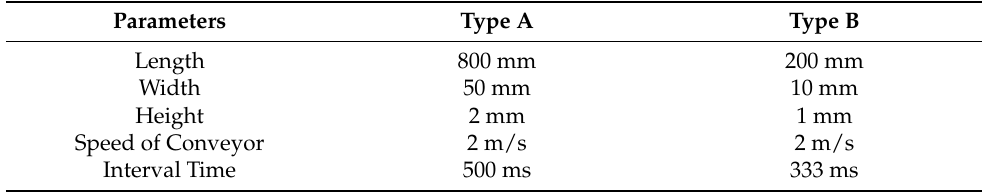
Table 1. Parameters of Test